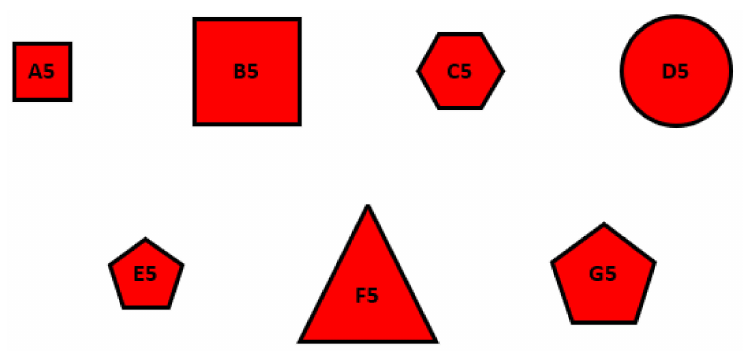
Figure 6. The fourth set of graphics.